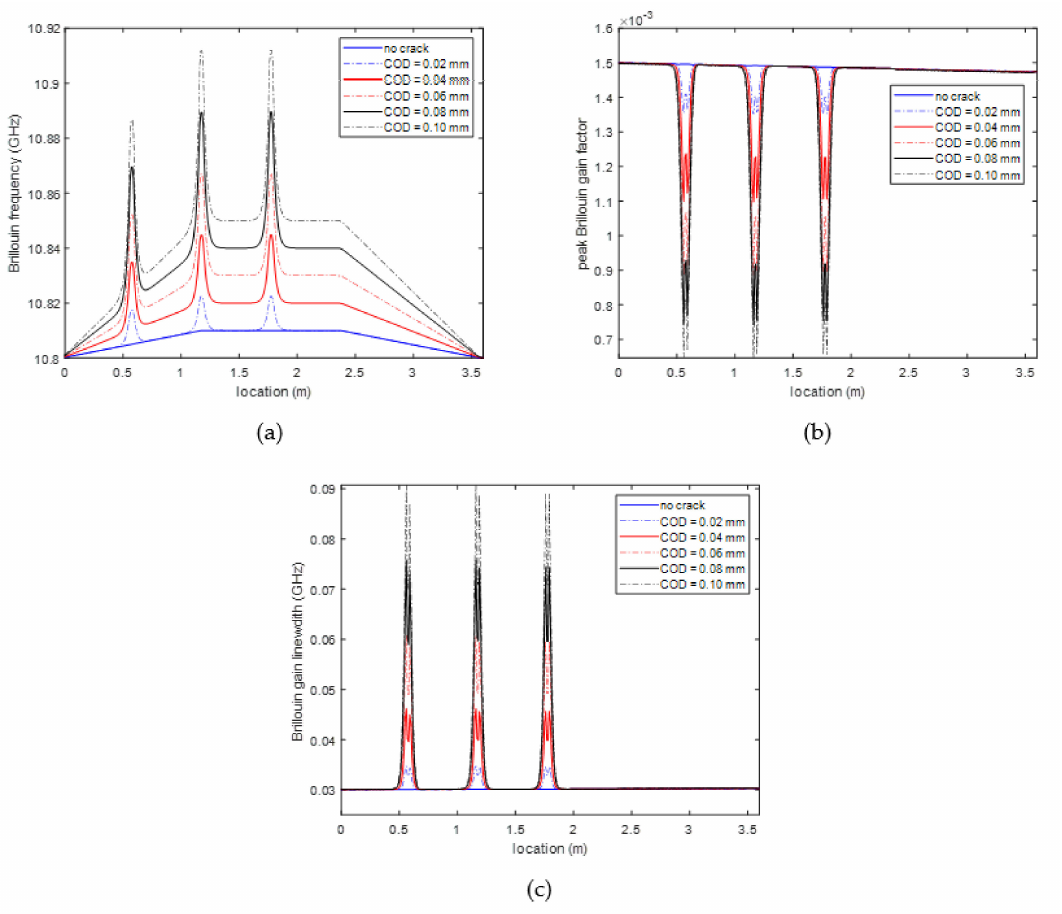
Figure 11. Identified Lorentzian model parameters along the fiber ( a ) Brillouin frequency ( b ) peak Brillouin gain factor ( c ) Brillouin gain